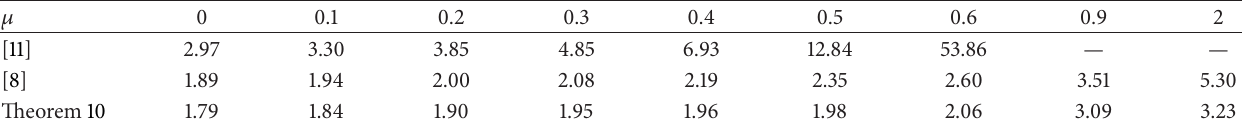
Table 2: Computed 𝛿 ’s of Example 1 for the case 𝜏 𝑚 ≤ 𝜏(𝑡) ≤ 𝜏 𝑀 , ̇𝜏(𝑡) ≤ 𝜇 with 𝜏 𝑚 = 0, 𝜏 𝑀 = 0.7 .